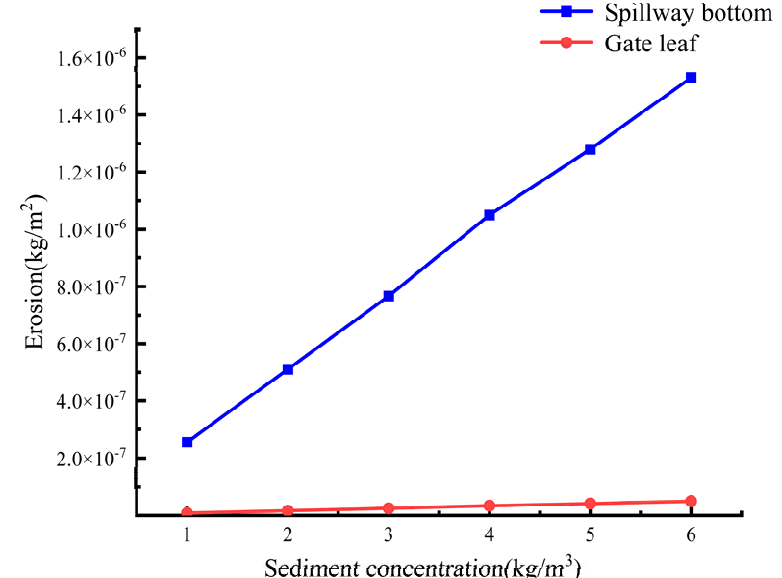
Figure 10. Relationship between erosion and sediment